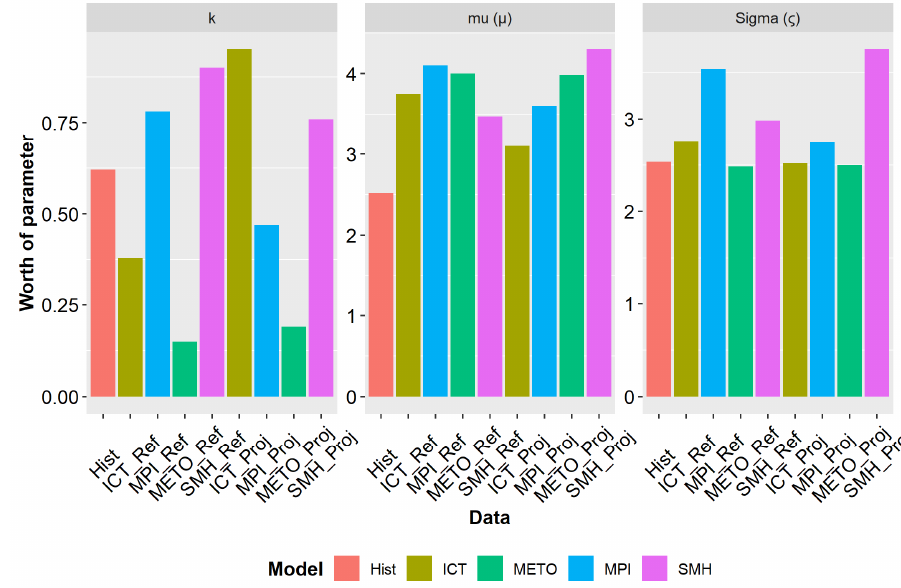
Figure 12. Temporal evolution of the three parameters (k, sigma, mu) of the Generalized Extreme Value (GEV) distribution for different sets of data.